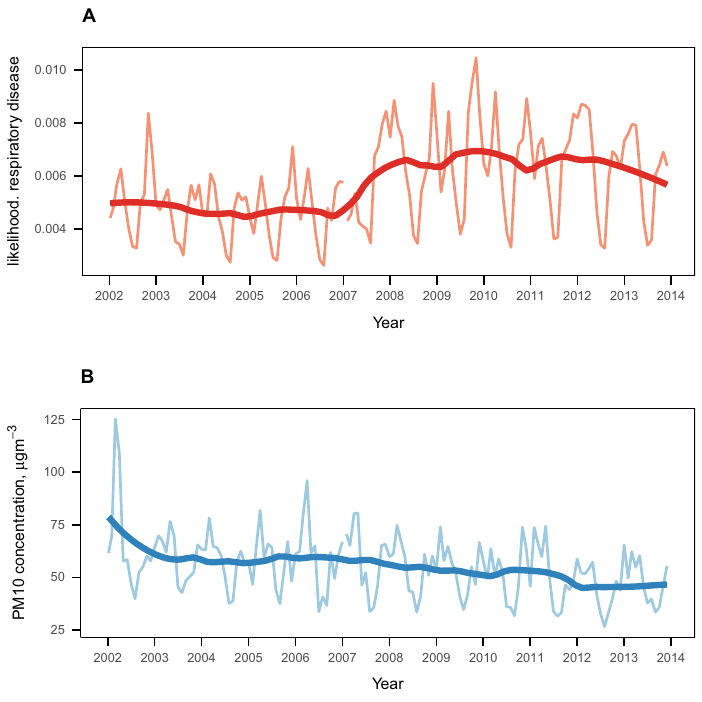
Fig 1. Time evolutions of the likelihood of respiratory disease and the PM 10 concentration during 2002–2013. ( A ) The monthly time series of the average likelihood of respiratory disease are represented by the pink line, accompanied by a smoothed fit of the mean likelihood according to a generalized additive model (red line). ( B ) The same as ( A ) but the mean of the PM 10 concentrations (light blue for the un-smoothed and blue for the smoothed series) are displayed.